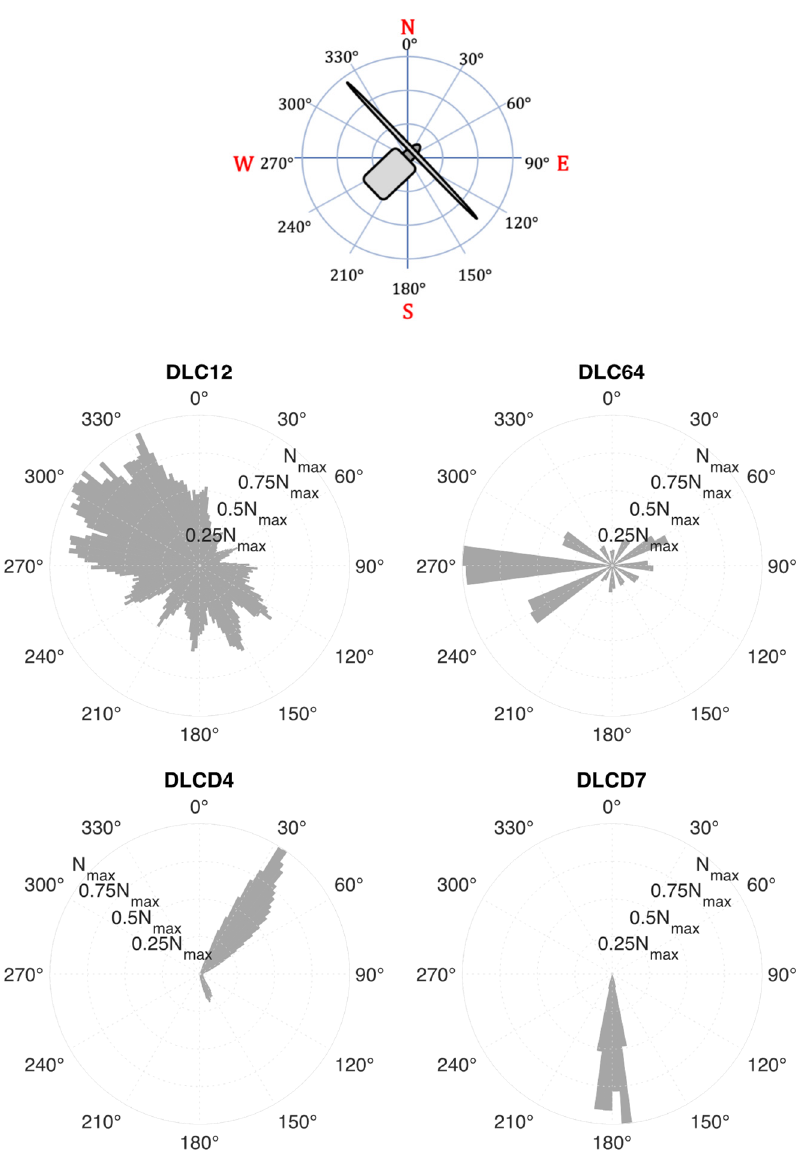
Figure 4. Distribution of the load cycles during the design life acting on the monopile support structure with respect to the global coordinate system.